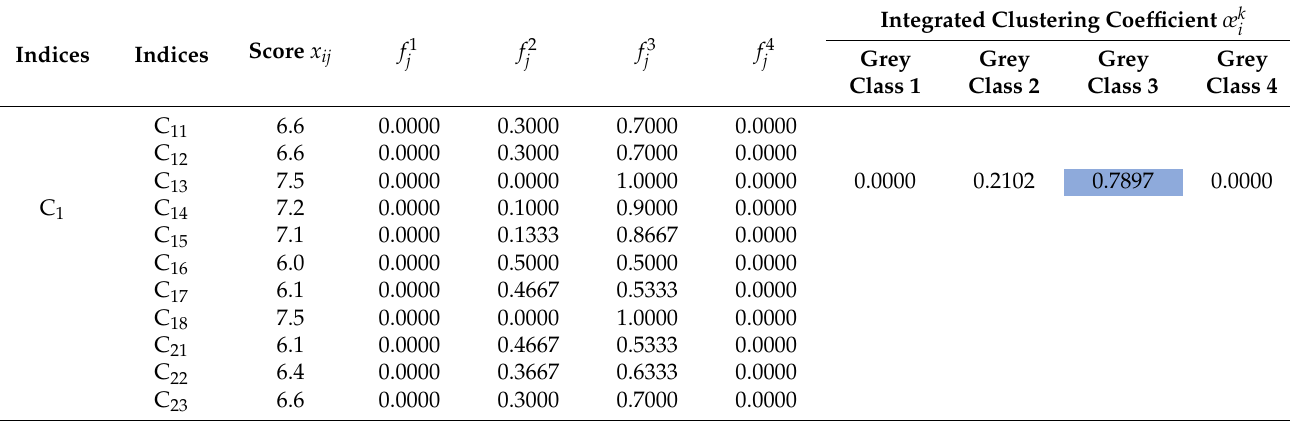
Table 7. Center point triangular whitening weight function values for each